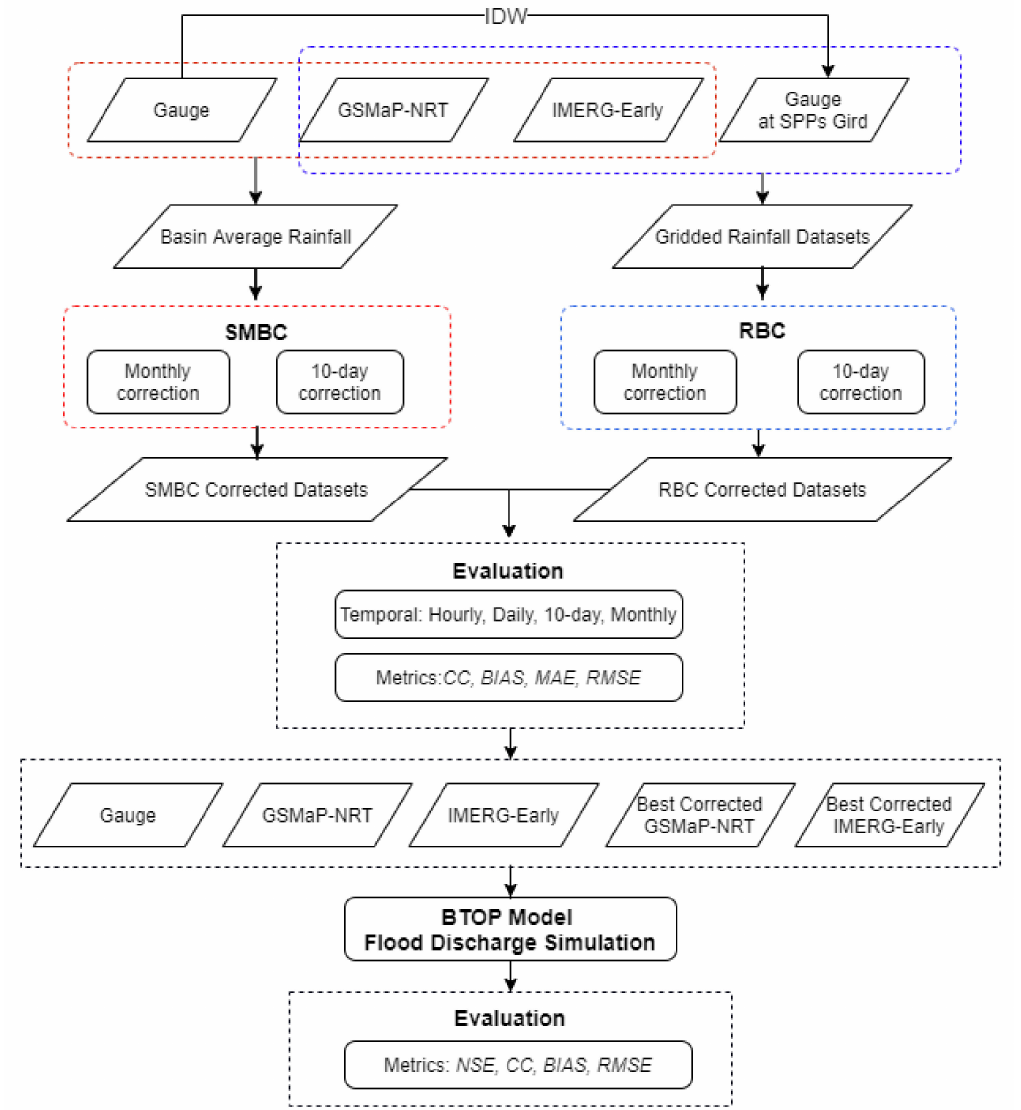
Figure 2. Framework of this